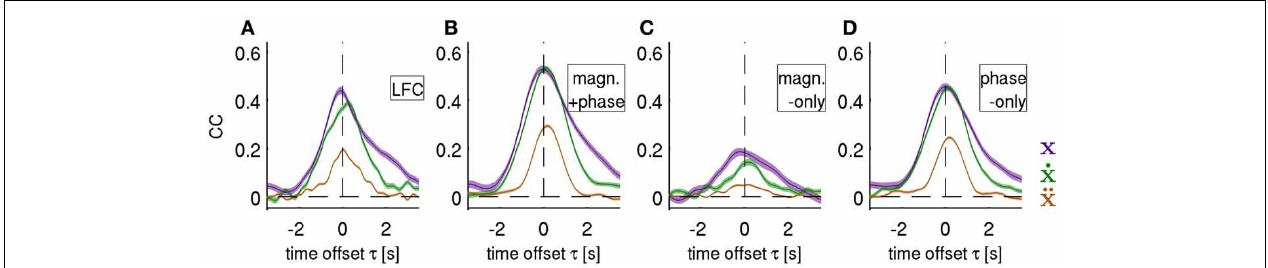
FIGURE 6 | Decoding of position, velocity and acceleration. Results obtained from decoding all ECoG grid channels as an average over all movement test sets (i.e., 3 × 30 validation folds) for subjects S1–S3. Mean CC ± s.e.m. as a function of time offset τ between ECoG predictors and decoded movement position (purple), velocity (green), and acceleration (brown). Negative values of τ indicate that the ECoG preceeds movement